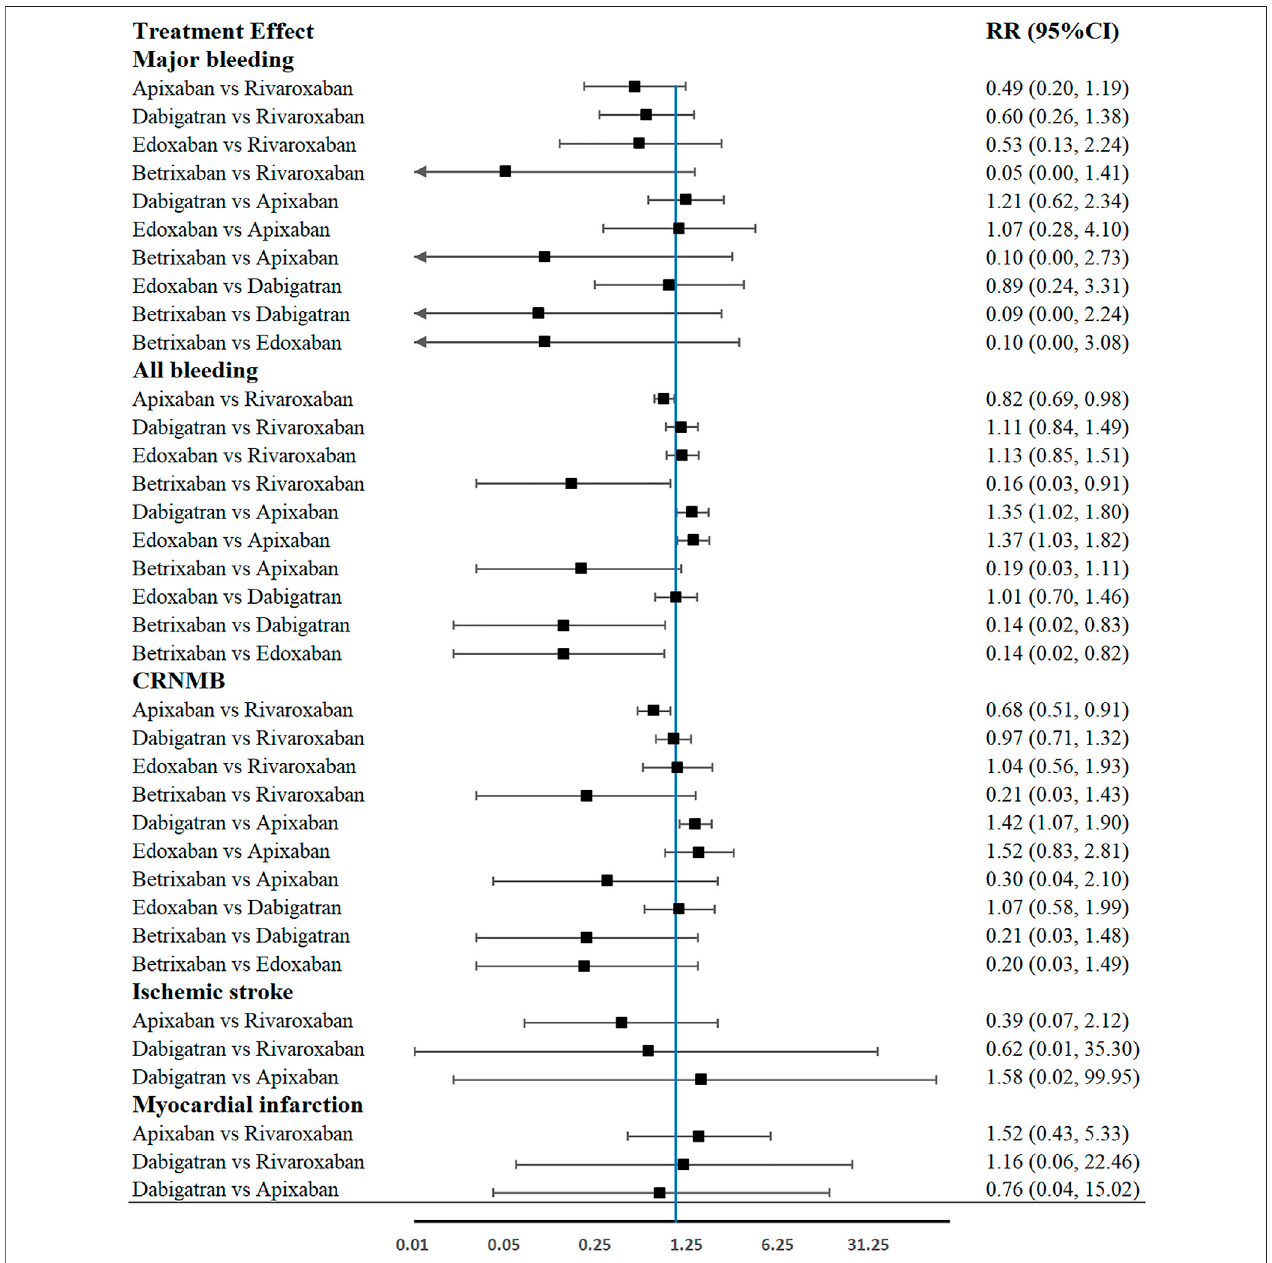
FIGURE 5 | Forest plot of network meta-analysis of different NOACs for major bleeding, all bleeding, CRNMB, ischemic stroke, and myocardial infarction in THA and TKA patients. CRNMB, clinically relevant nonmajor bleeding.